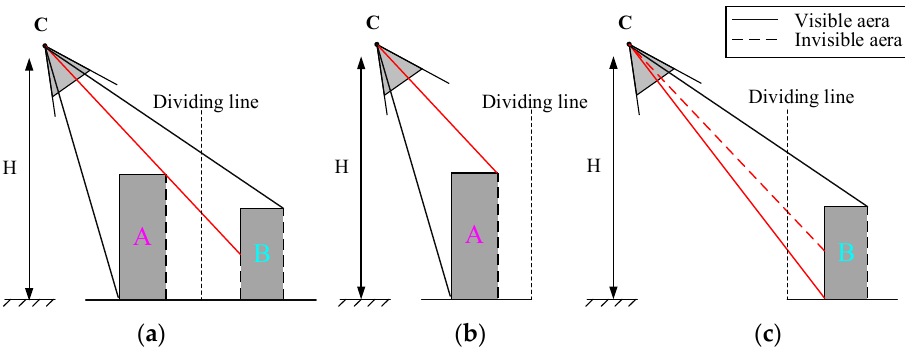
Figure 2. Occlusion relation error. ( a ) Original occlusion relation, ( b ) correct occlusion relationship after segmentation, and ( c ) incorrect occlusion relationship after segmentation.